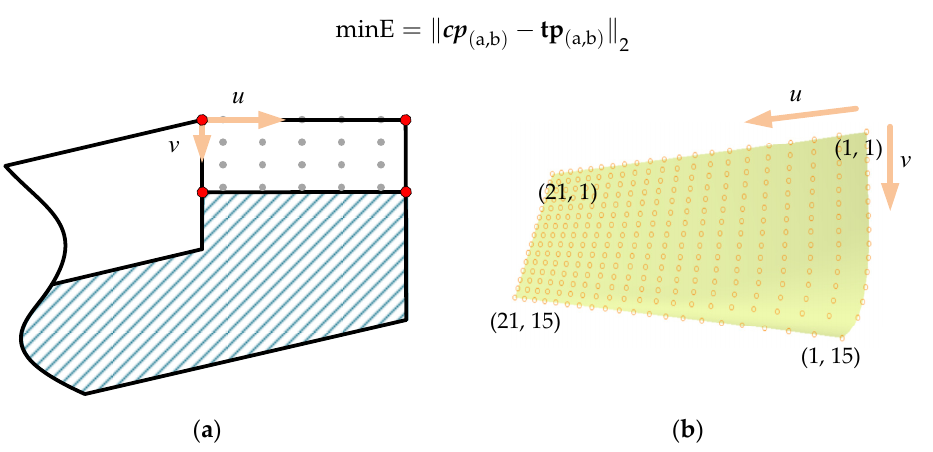
Figure 5. ( a ) The regularly discrete points on the theoretical tooth surface, and ( b ) the point cloud with numbered points.